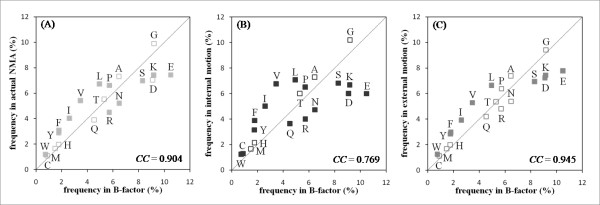
Comparison of amino acid frequency with large fluctuations in B-factor, actual NMA value, and internal, and external motions. (A) B-factor vs. actual NMA value, (B) B-factor vs. internal motion, and (C) B-factor vs. external motion are shown. Internal/external motion used values calculated using NMA. The horizontal and vertical axes respectively show the amino acid frequency with large fluctuations in the B-factor and actual NMA/internal/external motions. Data points close to the diagonal represent residues appearing with nearly equal frequency in B-factor and actual NMA/internal/external motions, although they deviated considerably from the diagonal represent residues appearing with different frequencies. Amino acids whose frequencies differ significantly based on t-test (p < 0.01) are shown as filled symbols. The CCs stand for the correlation coefficients between frequencies in B-factor and actual NMA/internal/external motions. The frequencies were estimated using 460 chains excluding NMR data from the dataset described in the Dataset section. The B-factor and three motions were normalized using the same method as that described in the Dataset section.